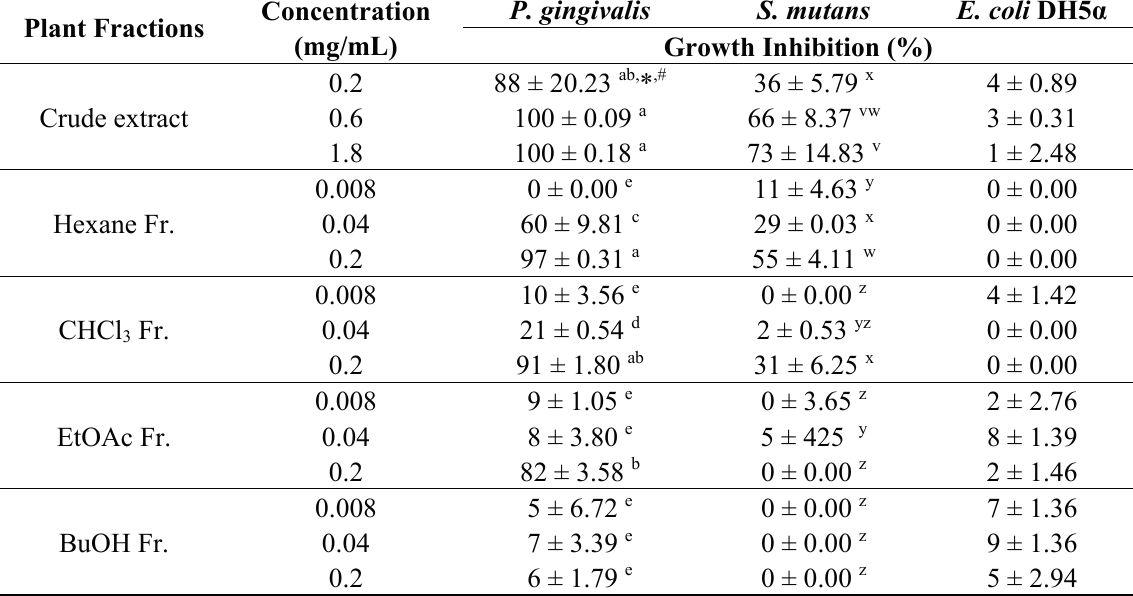
Table 1. Antibacterial activity of crude extract and fractions of Robinia pseudoacacia against the tested